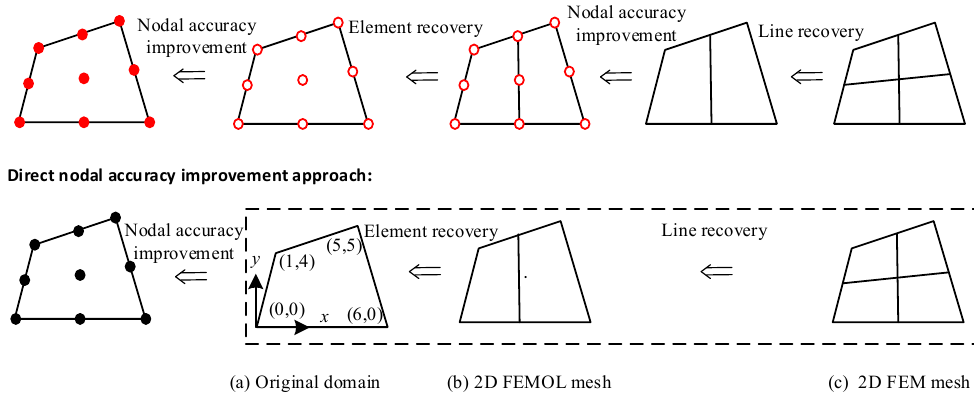
Figure 4. Two approaches for nodal accuracy improvement for 2D problems.